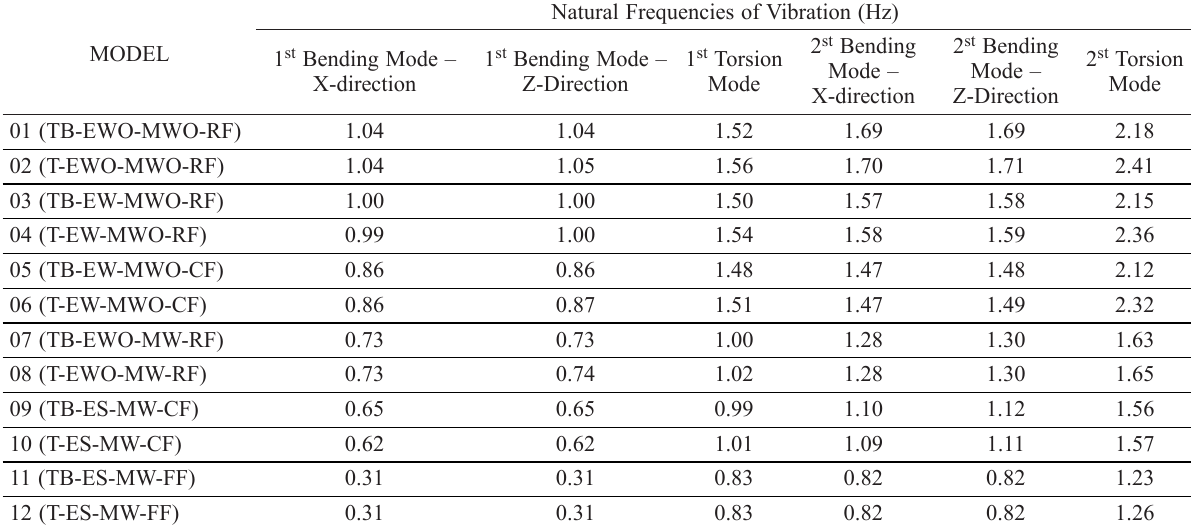
Table 1. First six natural frequencies and mode shapes of the tower GTS 01